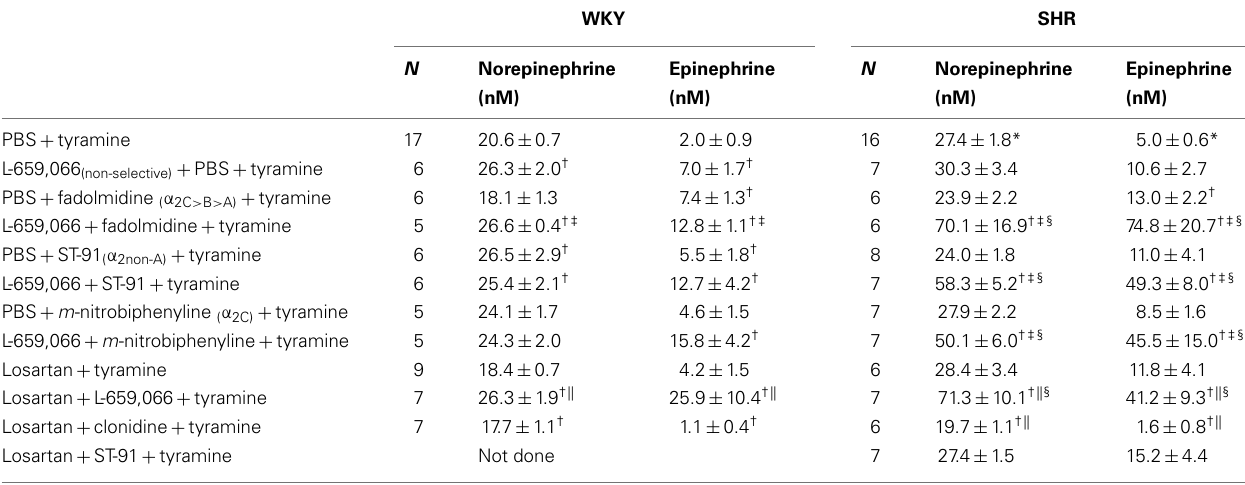
Table 2 |The plasma concentration of norepinephrine and epinephrine at the end of the tyramine-infusion